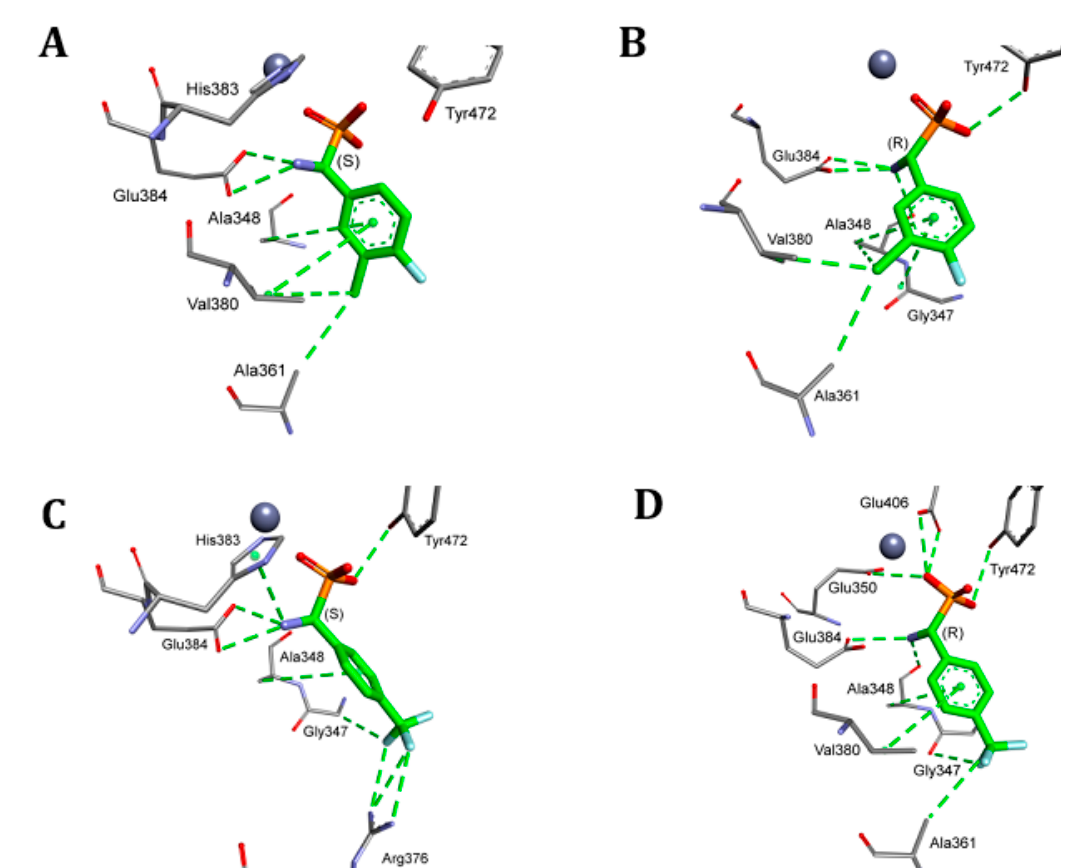
Figure 2. Mode of binding of both enantiomers of representative examples of phosphonic analogues of phenylglycine to porcine alanyl aminopeptidase (pAPN). A : S -isomer, B : R -isomer of compound 7 , C : S -isomer, D : R -isomer of compound 10 . All of the amino acids interacting even with even one of the inhibitors are shown. Atoms are colored as in Figure 1.